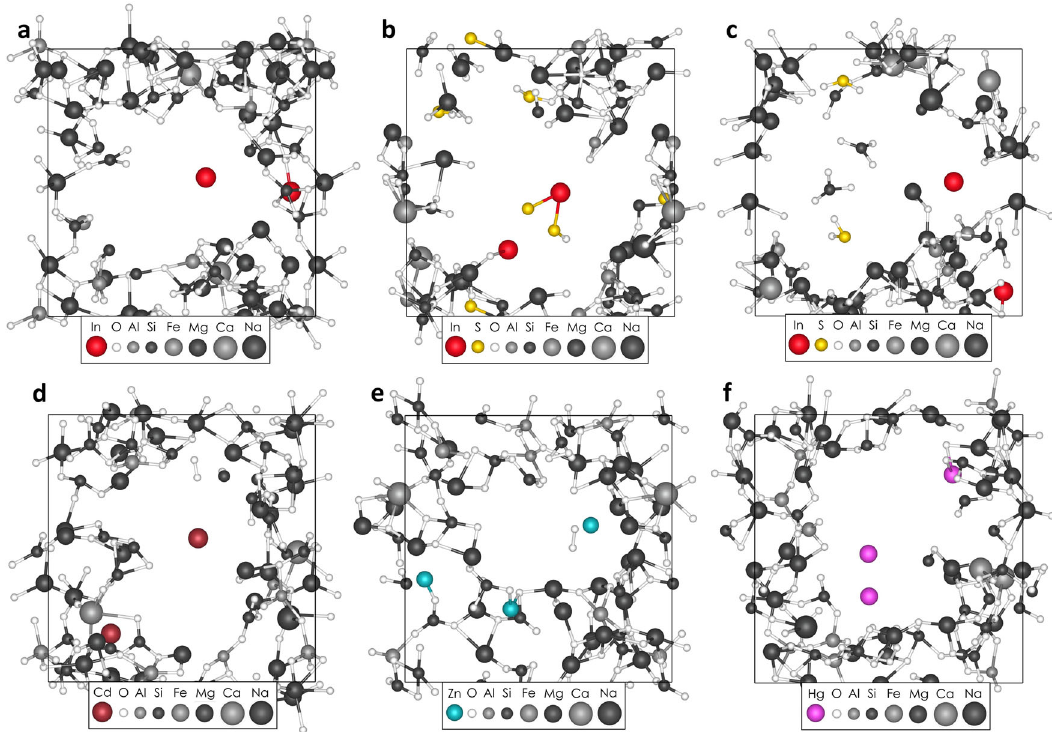
Fig. 2 Snapshots of the vaporization of In, Cd, Zn, and Hg from pyrolite melts at 5000 K and 1 g cm − 3 . a Vaporization of In 3 + (red) in the absence of S. b Vaporization of In 3 + (red) in the presence of S 2 − (yellow). c Vaporization of In 3 + (red) in the presence of S 6 + (yellow). The oxidation states of In and S are described as they were initially added to the silicate melts (e.g., In 2 O 3 ) and are not constrained during the simulation. d Cd-bearing pyrolite melt with Cd, O 2 , and SiO species in the vapor phase. e Zn-bearing pyrolite melt with Zn and O 2 species in the vapor phase. f Hg-bearing pyrolite melt with two Hg atoms in the vapor